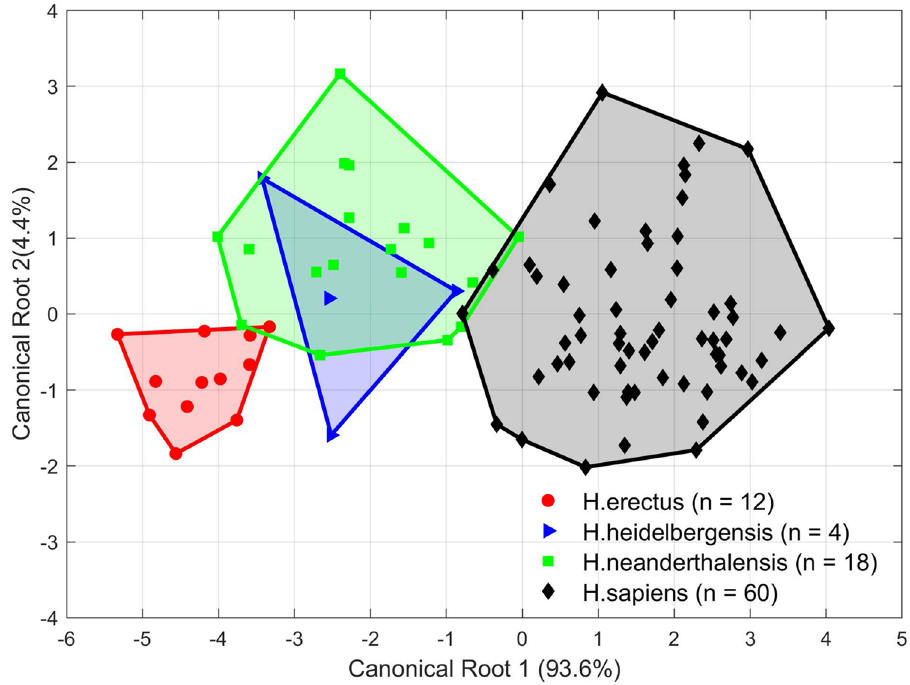
Figure 8. Canonical plot of the 94 human mandibles from four groups ( H. erectus , H. heidelbergensis , H. neanderthalensis , and H. sapiens ) based on the orientation changes between segments (19 variables).